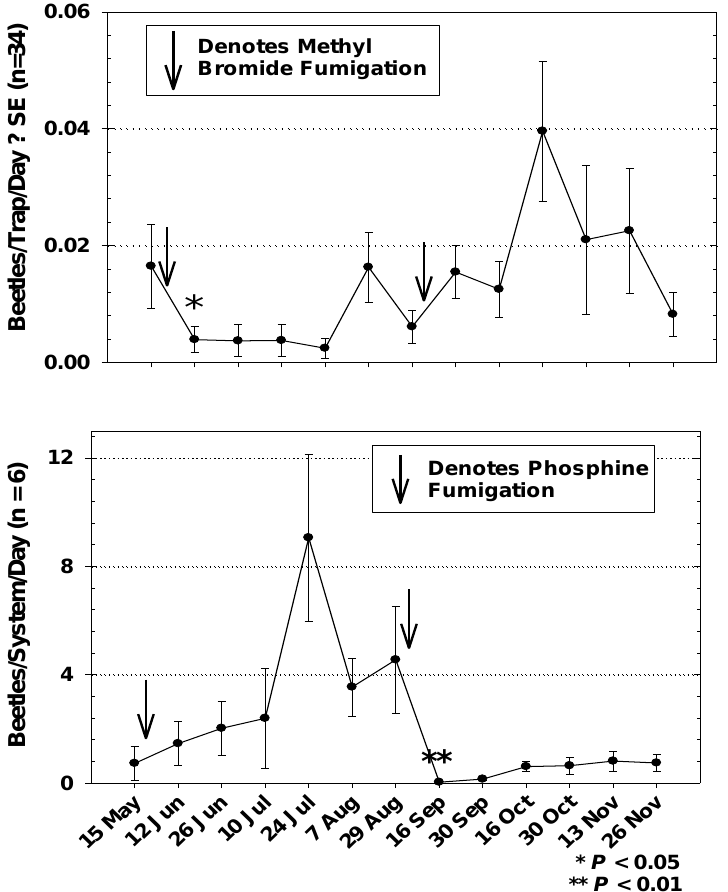
Figure 5. Trap capture throughout mill 1 (top graph) and counts of T. castaneum from six load-out system tailings during Year 1 (bottom graph). Results are from biweekly observations from 34 pitfall traps. Load-out counts are consolidated to correspond with trapping times and intervals. Arrows denote fumigations on 31 May and 30 August. Significantly fewer numbers of beetles were trapped following the 31 May methyl bromide fumigation ( t = 2.13; df = 23; p = 0.0455, shown with a * in the top graph), but not after the 30 August fumigation. Significantly fewer beetles were sampled from tail-overs following the 30 August phosphine fumigation ( t = 6.83; df = 5; p = 0.0010, shown with ** in the bottom graph), but not following the 31 May fumigation. Count data for t-tests were square root